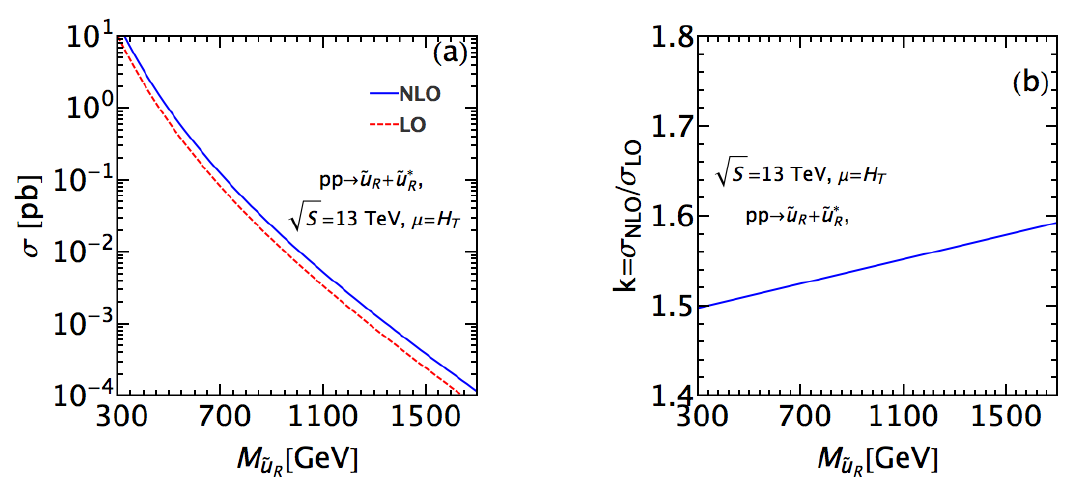
Figure 8 . The production cross section (left) and k -factor (right) for mediator pair production via QCD at the 13 TeV LHC. Here, we have summed over contributions from the ~ q ~ q , ~ q ~ q (cid:3) and ~ q (cid:3) ~ q (cid:3) (cid:12)nal states in each